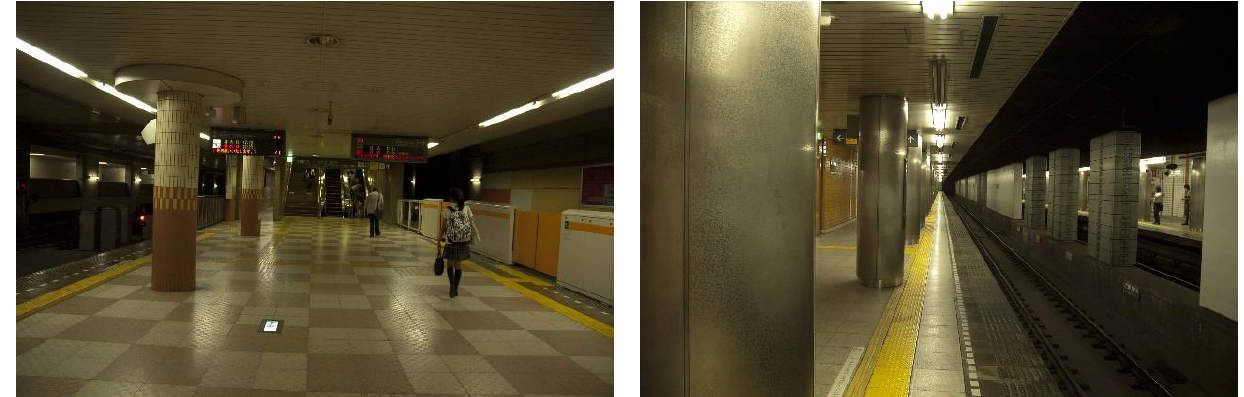
Figure 8. Comparison of No. 8 (left) and No. 11 (right).